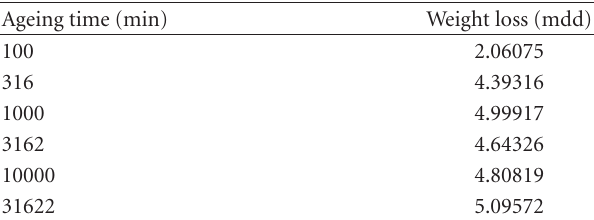
Table 3: Weight loss immersion acid test results according to ASTM A